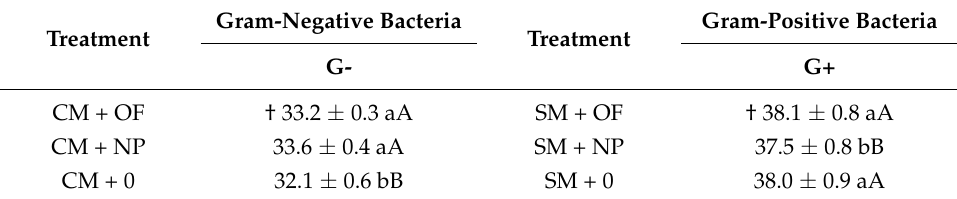
Table 5. Influence of fertilizer treatment on Gram-negative bacteria and Gram-positive bacteria (%). Values are the average ± 1 standard